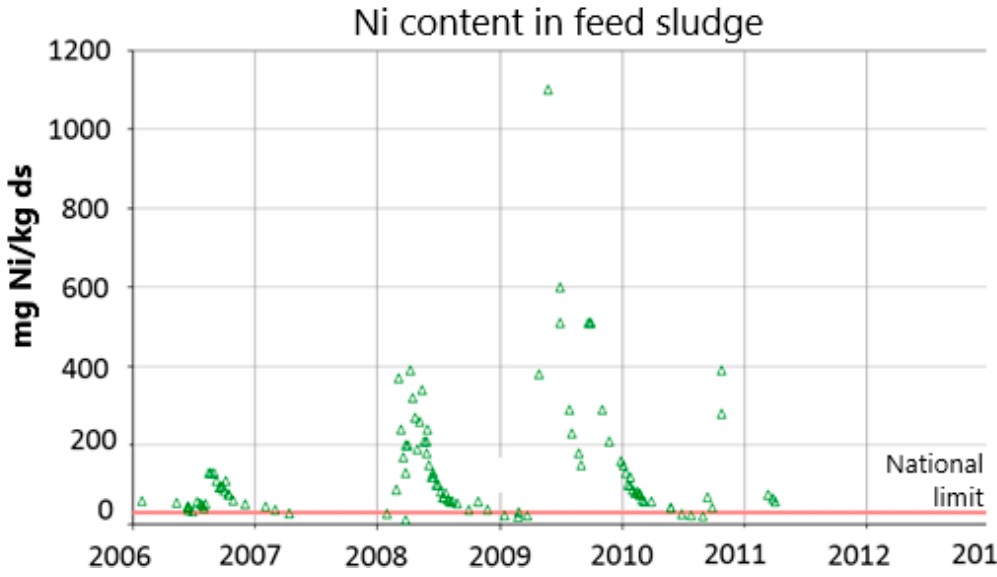
Figure 6. Nickel concentration (mg Ni/kg ds) in the feed sludge at an STRB in Stenlille (Denmark) [53]. The red line represents the Danish national limit for Ni in sludge recycled in agriculture (30 mg Ni/kg ds).